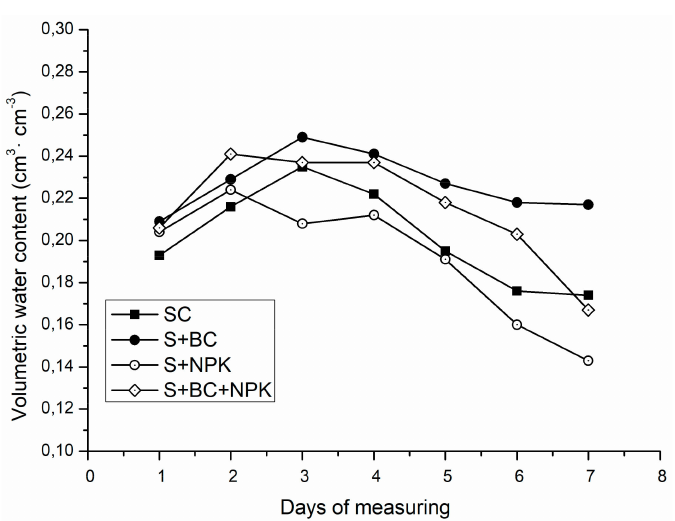
Figure 1. E ff ect of biochar and fertilizer on volumetric water content (VWC). SC- control set (only sand), S + BC – sand with biochar, S + NPK – sand with mineral NPK fertilizer, S + BC + NPK – sand with biochar and